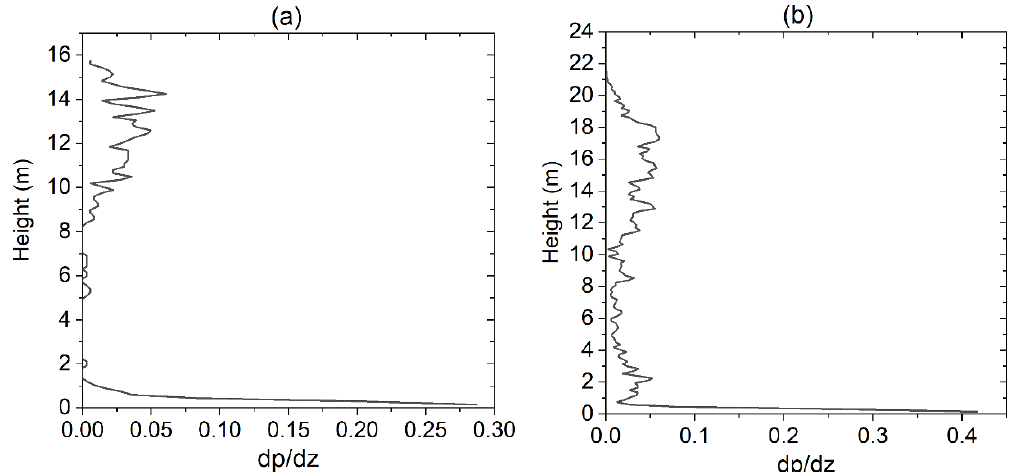
Figure 6. Two patterns of the derivative of the gap probability along the vertical direction with respect to height: ( a ) with an obvious gap stratum; ( b ) without an obvious gap stratum.